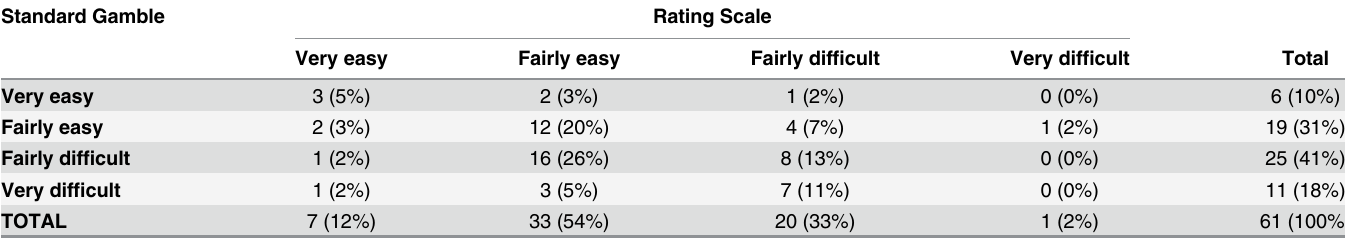
Table 4. Concordance between the levels of difficulty between the RS and the SG in the development